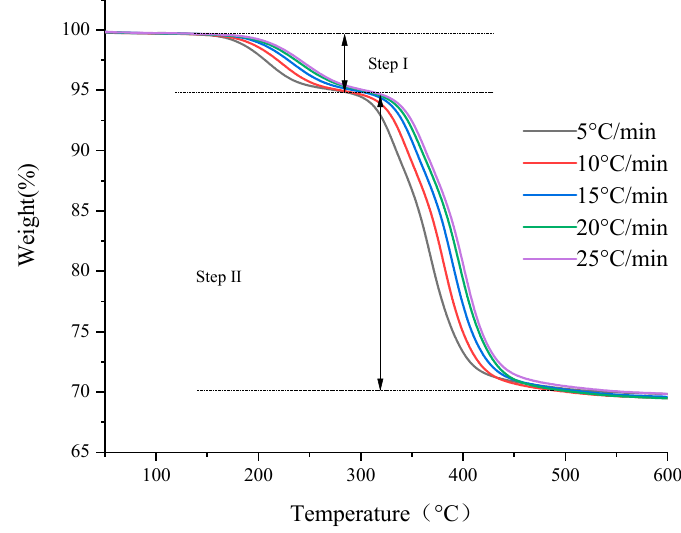
Figure 1. Thermogravimetric curves of the basin insulator.